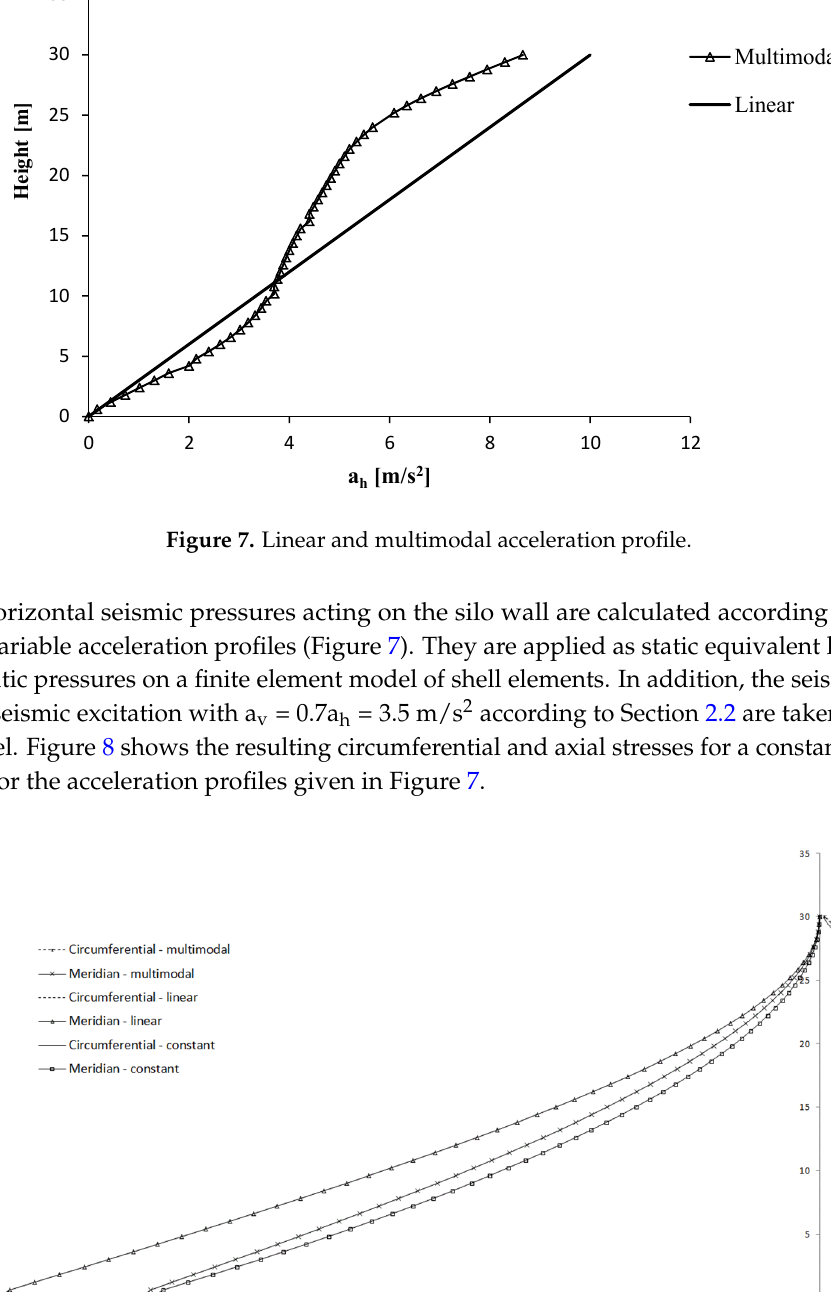
Figure 6. Design response spectrum according to the seismic code of New Zeeland, Soil Class E [22].